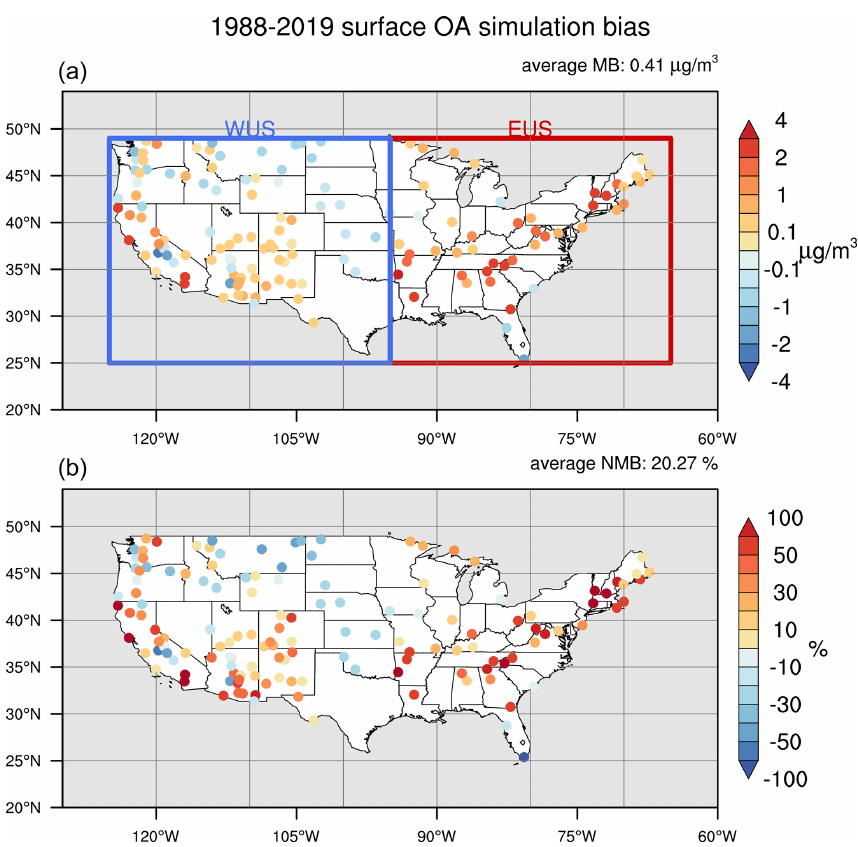
Figure 1. The 1998–2019 CAM-Chem-SD surface OA concentration mean bias ( a ; unit: µgm − 3 ) and normalized mean bias ( b ; unit: %) compared with IMPROVE data. CONUS is divided into two subdomains: EUS (red box) and WUS (blue box). Table 1. Aircraft measurements used in this